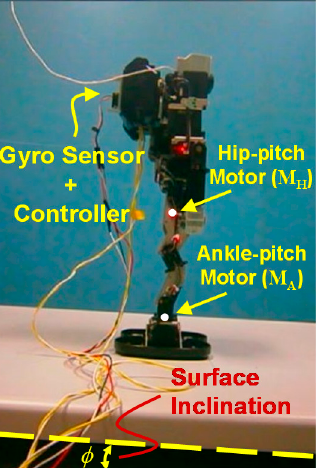
Figure 1. KONDO KHR-3HV humanoid robot integrated with a gyro sensor for balancing on an inclined surface with the inclination angle φ .